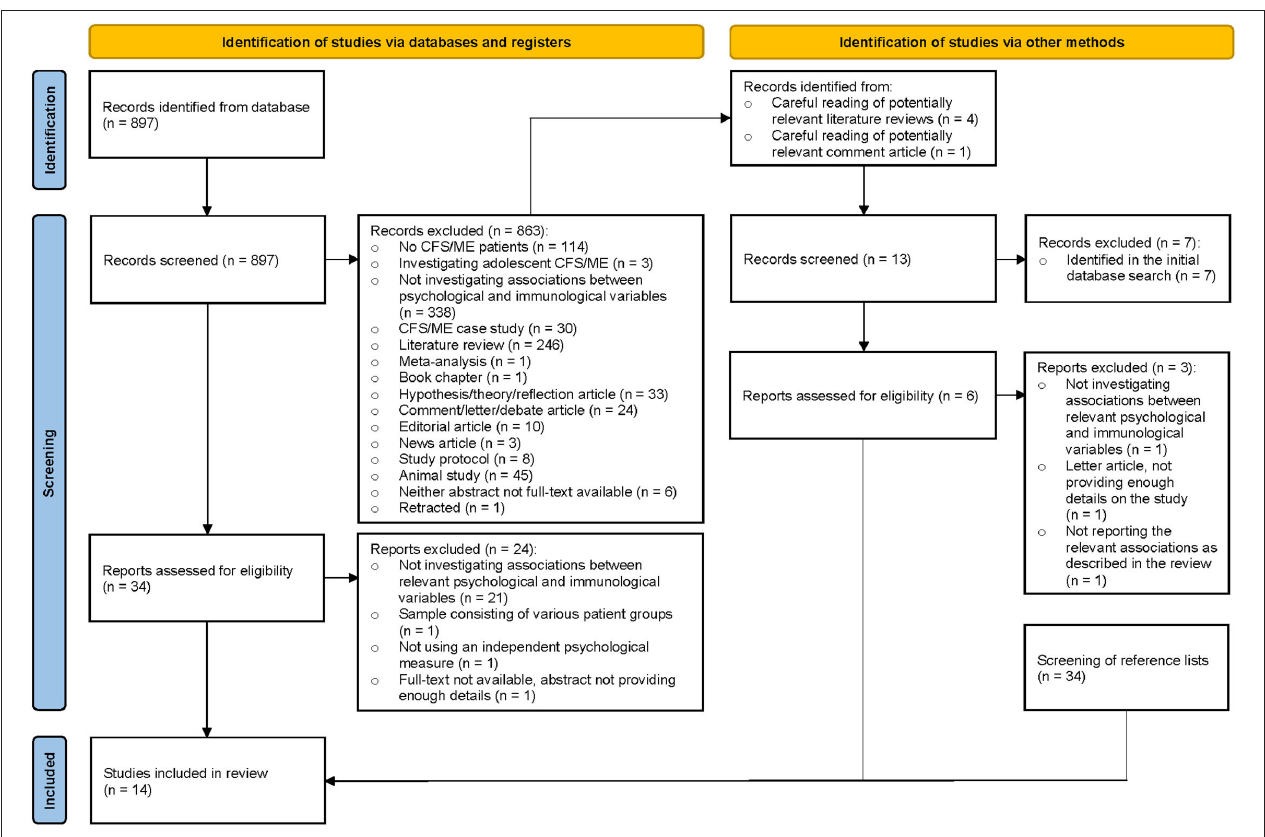
FIGURE 1 | PRISMA flow-diagram summarizing the literature search and screening process (36).